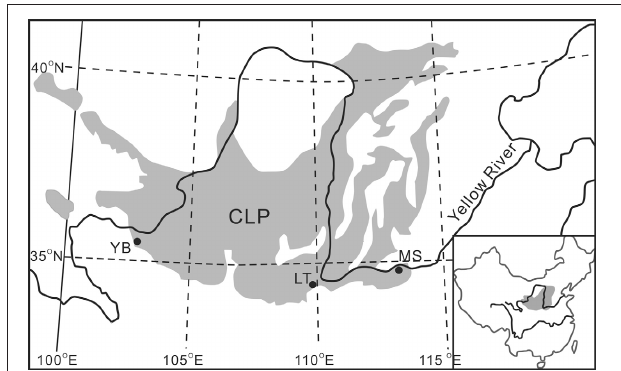
FIGURE 2 | Chinese Loess Plateau (CLP) and the site of Yuanbao (YB) in this study. Sites LT (Lantian) and MS (Mangshan) have been studied for MBT-CBT temperature records by others and are mentioned in this paper.